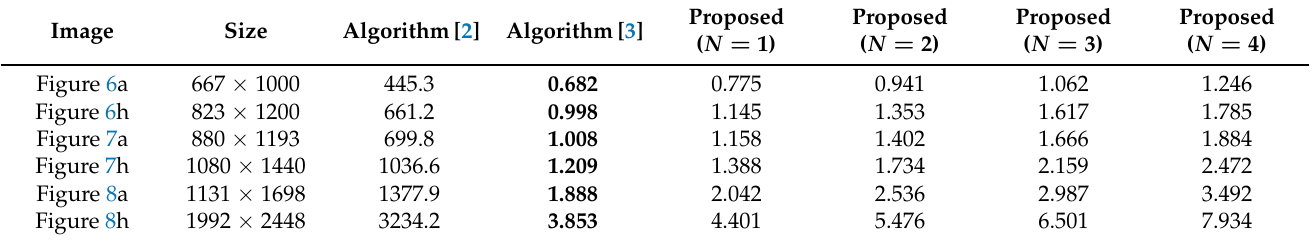
Table 2. Computation time of the reflection suppression results in Figure 6. The best value in each row is shown in